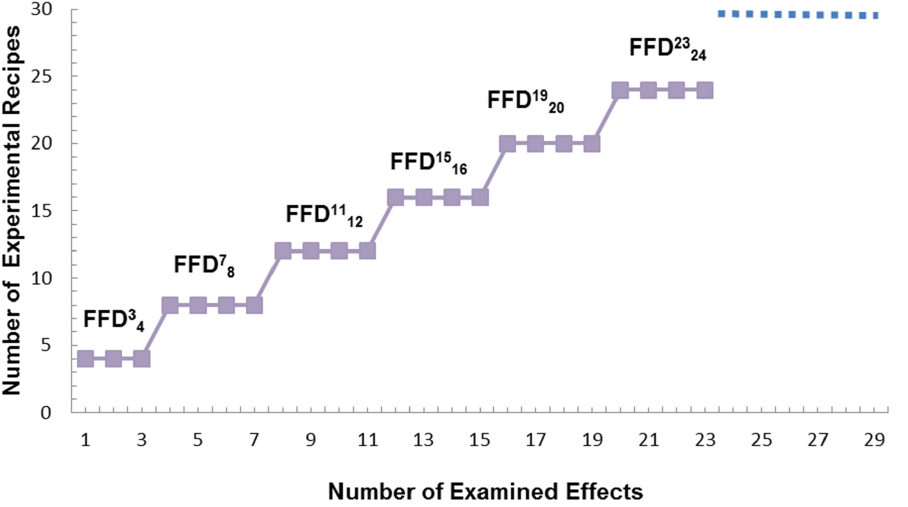
Figure 1. The quantized plateau for increasing trial-run capacity in FFD k the number of examined effects.